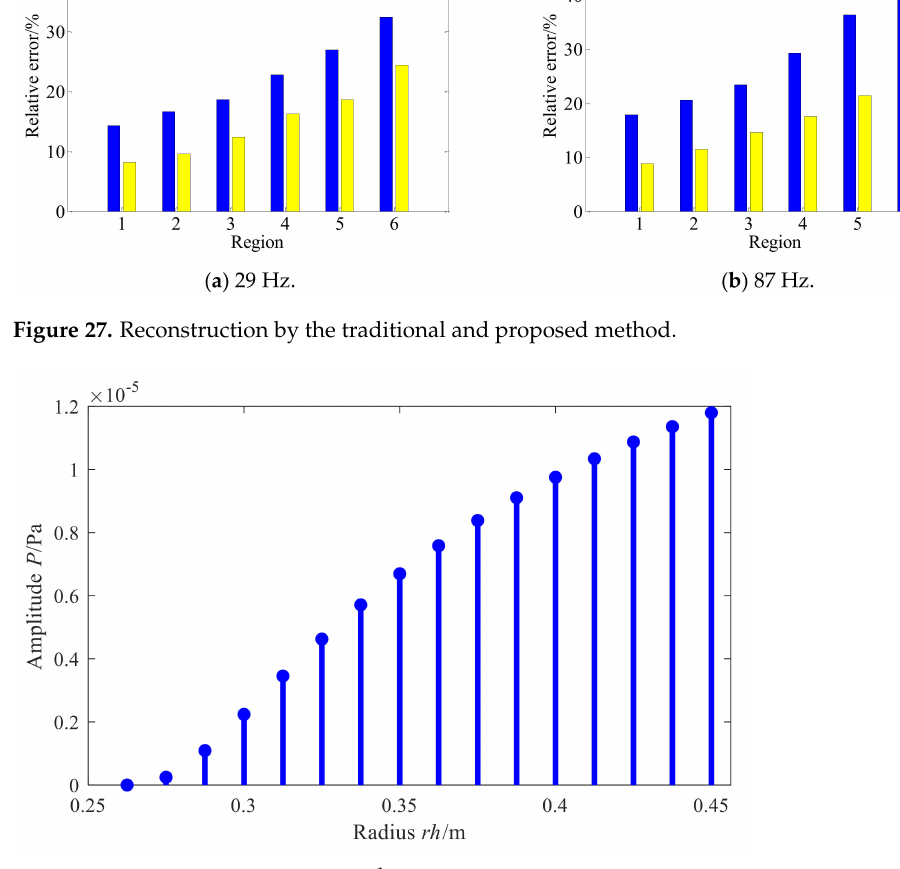
Figure 28. Amplitude variation of Φ β